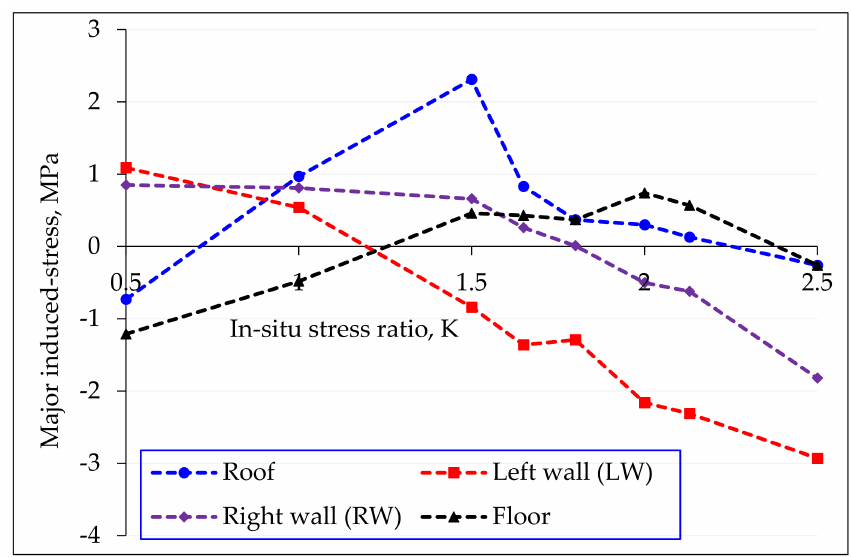
Figure 8. Induced-stress against in situ stress ratio around tunnel boundary.